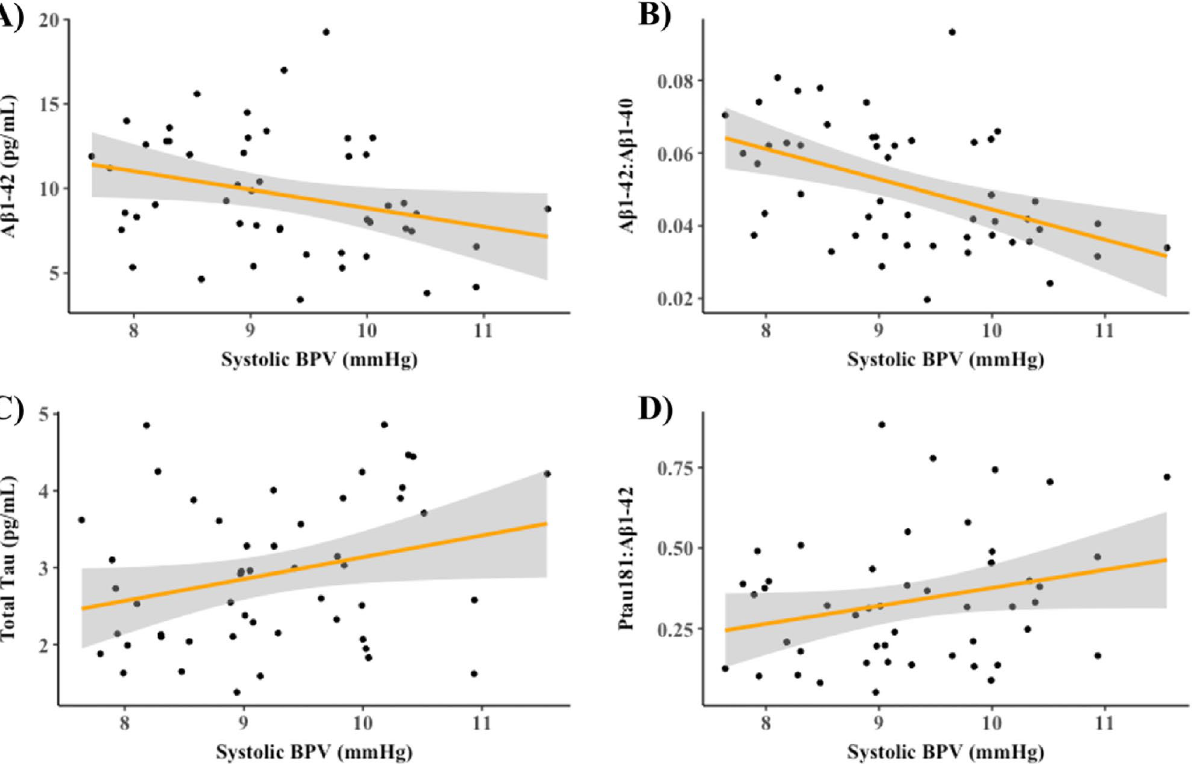
Figure 1. Elevated short-term systolic BPV is associated with plasma AD biomarkers in older adults. Scatterplots display the relationship between short-term systolic BPV and ( A ) Aβ 1–42 , ( B ) Aβ 1–42 : Aβ 1–40 , ( C ) total tau and ( D ) Ptau 181 : Aβ 1–42 plasma AD biomarker levels in older adults. Lines are shaded with 95% CI. Plasma values were adjusted for age, sex, and APOE e4 carrier status. BPV blood pressure